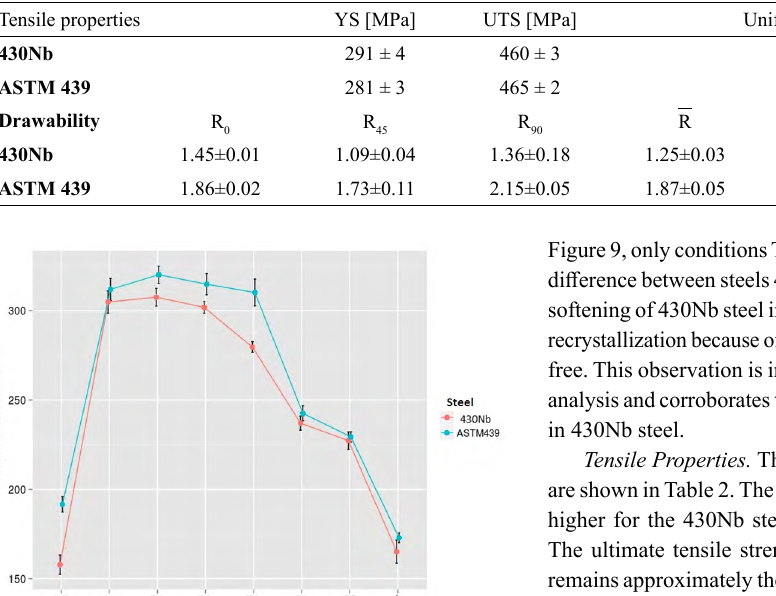
Table 2. Tensile properties and drawability results for the studied